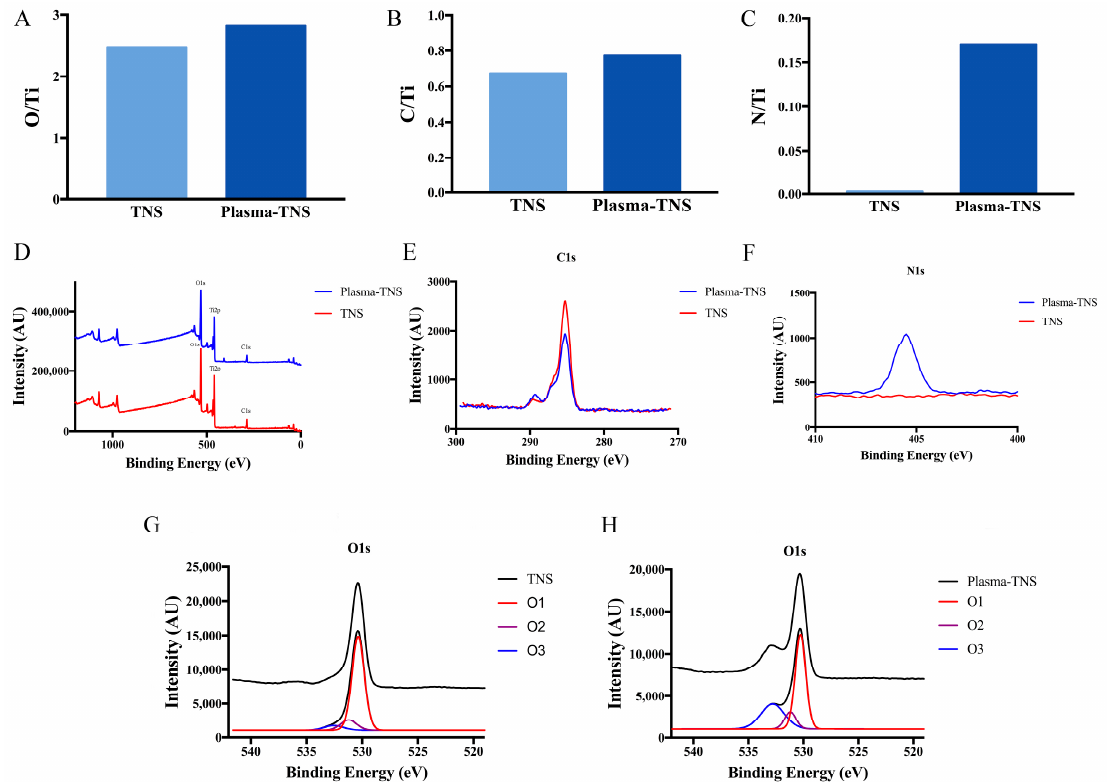
Figure 2. XPS analysis on the surface of TNS and plasma-TNS presented as the mean calculated from the random location of three samples: ( A ) oxygen/titanium ratio, ( B ) carbon/titanium ratio, ( C ) nitrogen/titanium ratio, ( D ) Wide-survey XPS spectra of the specimens, ( E ) high-resolution spectra of carbon 1 s, ( F ) high-resolution spectra of nitrogen 1 s, and high-resolution spectra of oxygen 1 s on the surface of ( G ) TNS and ( H ) plasma-TNS, respectively.